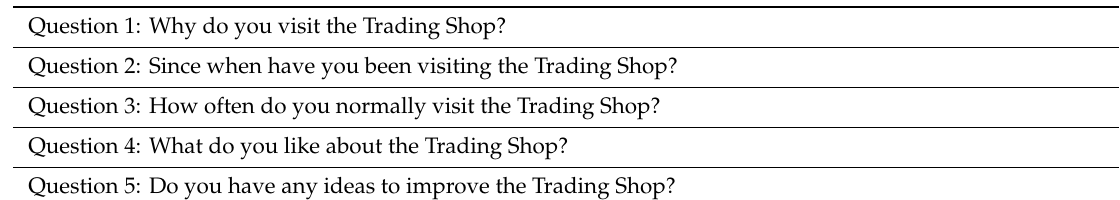
Table 2. Interview guide visitors /